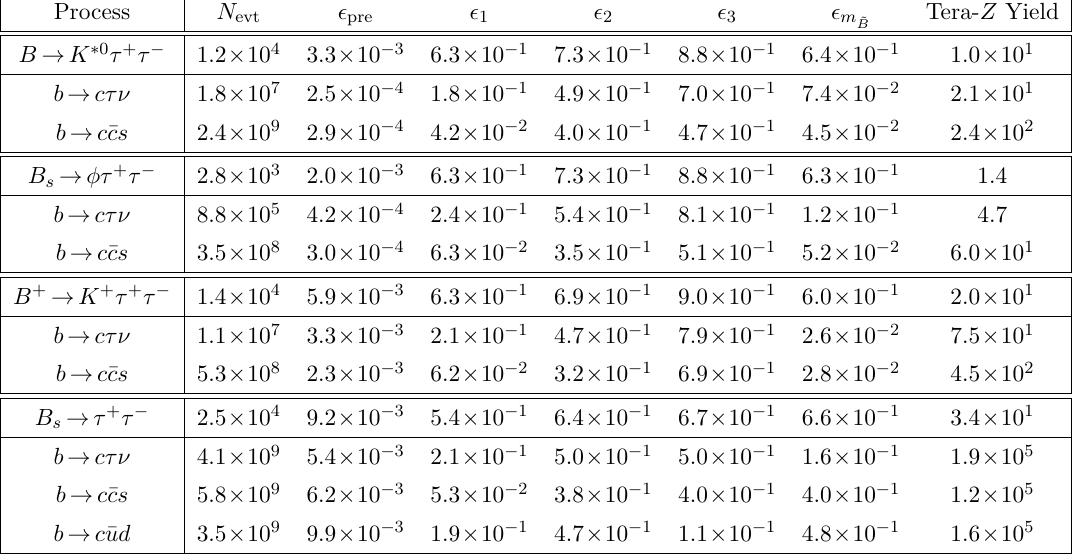
At last, a mass window cut is applied for the reconstructed B mesons, namely | m m | < 0 . 02 GeV for the first three b → sτ + τ − measurements and m ˜ B B → τ + τ − s